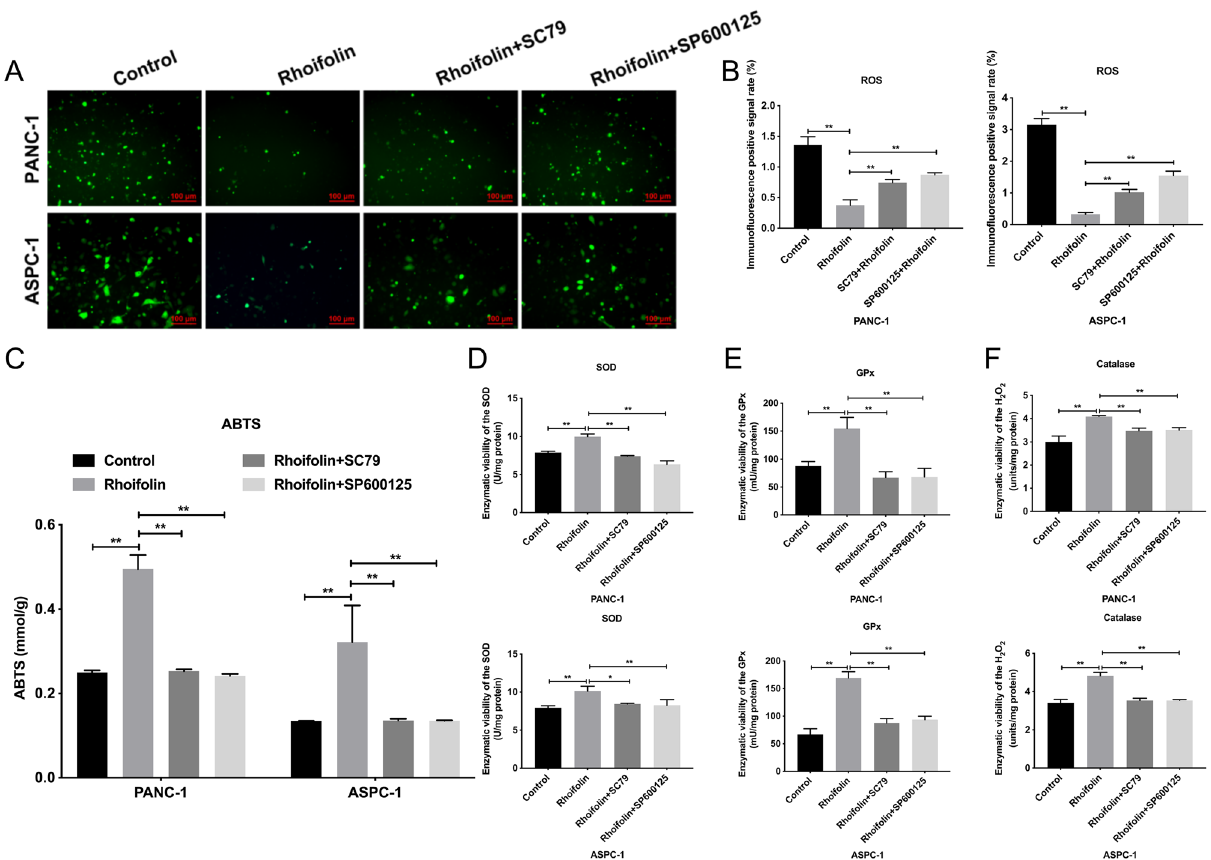
Figure 5. AKT activator or JNK inhibitor could reverse the enhanced antioxidant capacity of Rhoifolin in pancreatic cancer cells. Rhoifolin-treated PANC-1 and ASPC-1 cells were also addressed with AKT activator (SC79) or JNK inhibitor (SP600125). (A) ROS level was assessed using DCFH-DA in ROS examination kit. (B) The positive rate of ROS in (A) was quantified. (C) The antioxidant capacity was evaluated using the ABTS kit. SOD (D) , GPx (E) , and catalase (F) levels were monitored by applying the corresponding